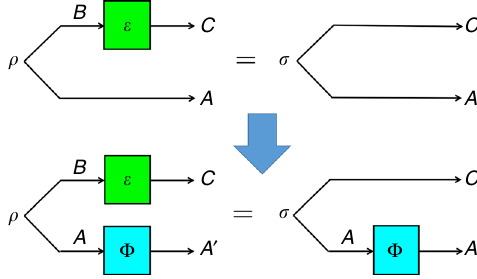
Fig. 1 Quantum majorization. The condition of quantum majorization σ AC (cid:2) ρ AB implies the in fi nite set of relations ð Φ (cid:5) id Þð σ AC Þ (cid:2) q ð ρ AB Þ , where Φ is any CPTP map acting on system A (cfr. Eq. (2) in